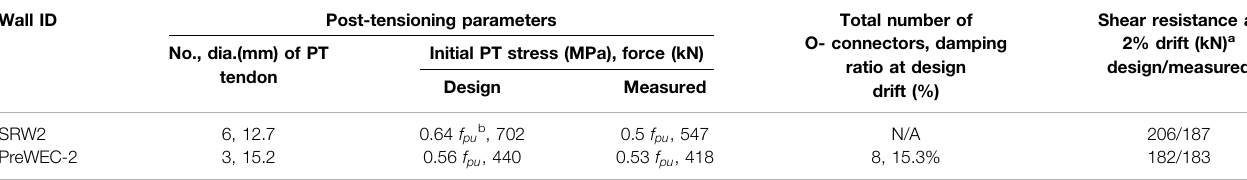
TABLE 1 | Summary of design variables for SRW2 and PreWEC-2. Wall ID